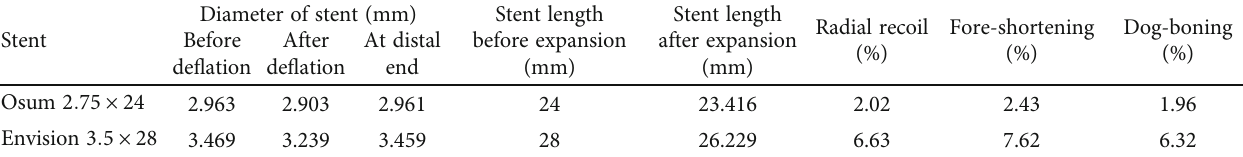
Table 3: Expansion characteristics of Osum and Envision stents from experiment.